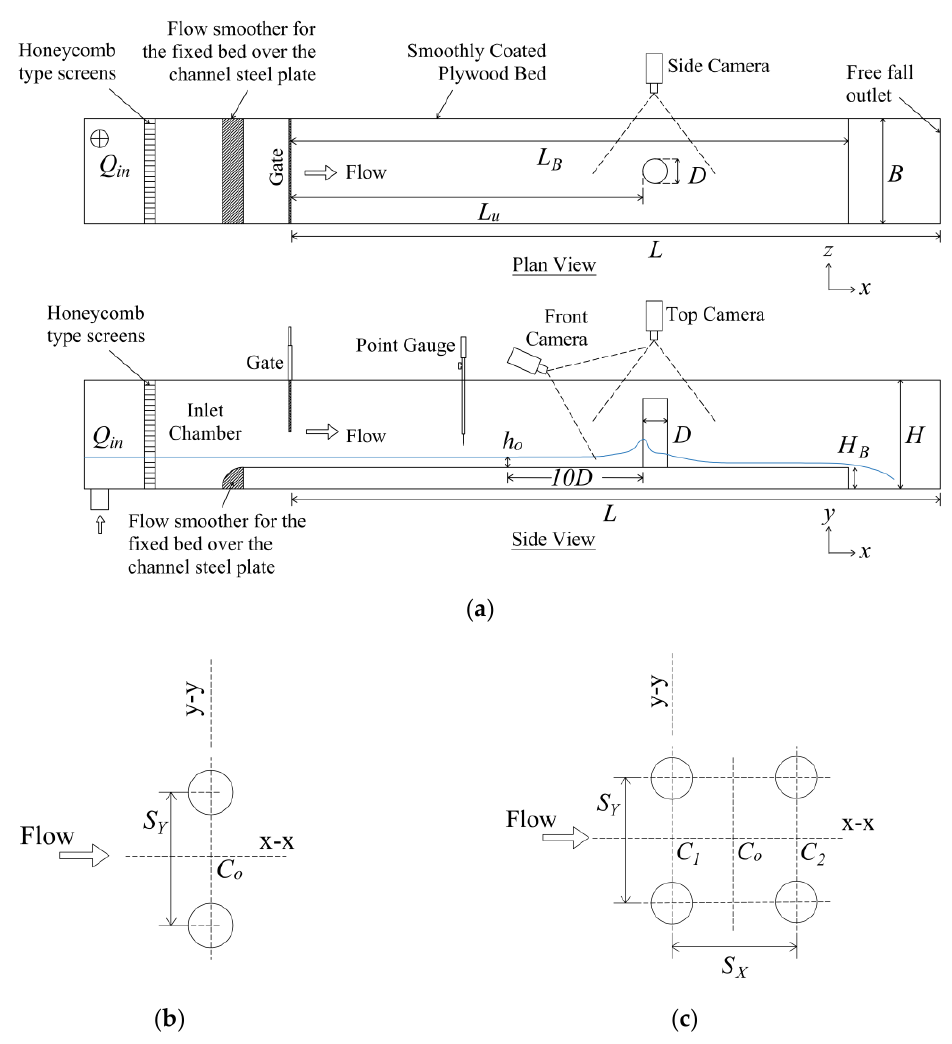
Figure 1. Schematic of the experimental setup and side - by - side cylinder arrangement: ( a ) plan view and side view of the experimental setup inside the channel, ( b ) two - cylinder array (case C2 (C2 - 1 or C2 - 2)) set up inside the channel, ( c ) four - cylinder array (case C4 (C4 - 1 or C4 - 2)) set up inside the channel.